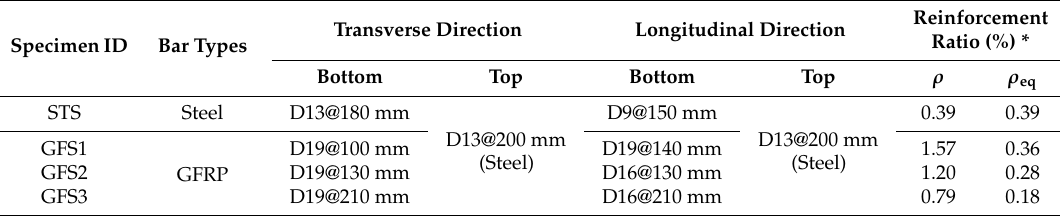
Figure 1. Specimen details of the full-scale, two-way concrete slab specimens (unit in mm). Table 2. Reinforcement details of the two-way concrete slab specimens.